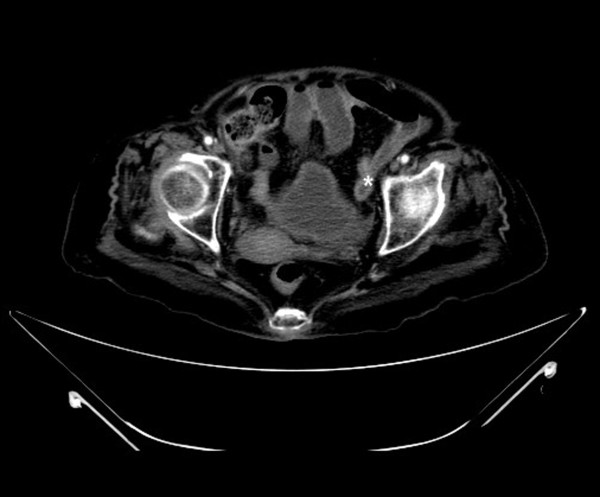
Abdominal computed tomography. Coronal view reveals a transitional region (asterisk) at the left lower abdomen.